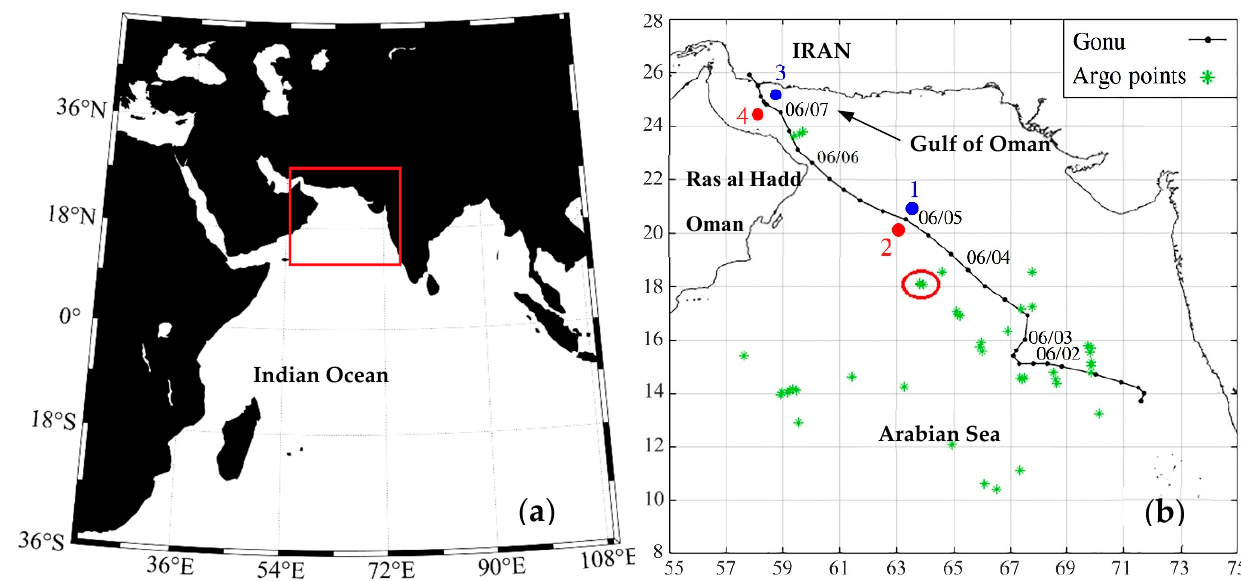
Figure 1. ( a ) Overall location of the Arabian Sea and Gulf of Oman in the northern Indian Ocean. ( b ) Track of Cyclone Gonu in the NAS and Gulf of Oman. Locations of Argo floats available in the study area during Gonu are shown with green asterisks.